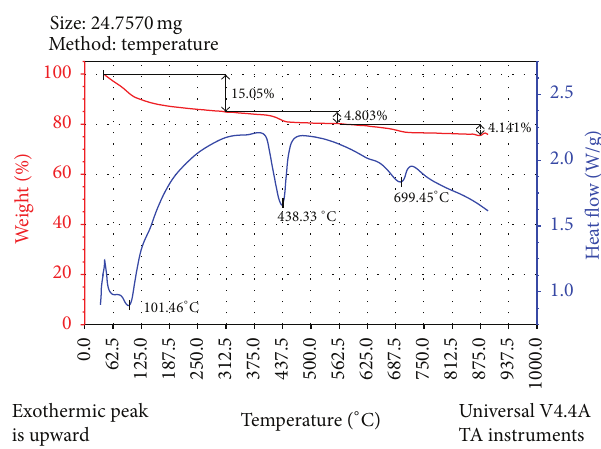
Figure 13: The DSC-TG curves of pure cement paste.